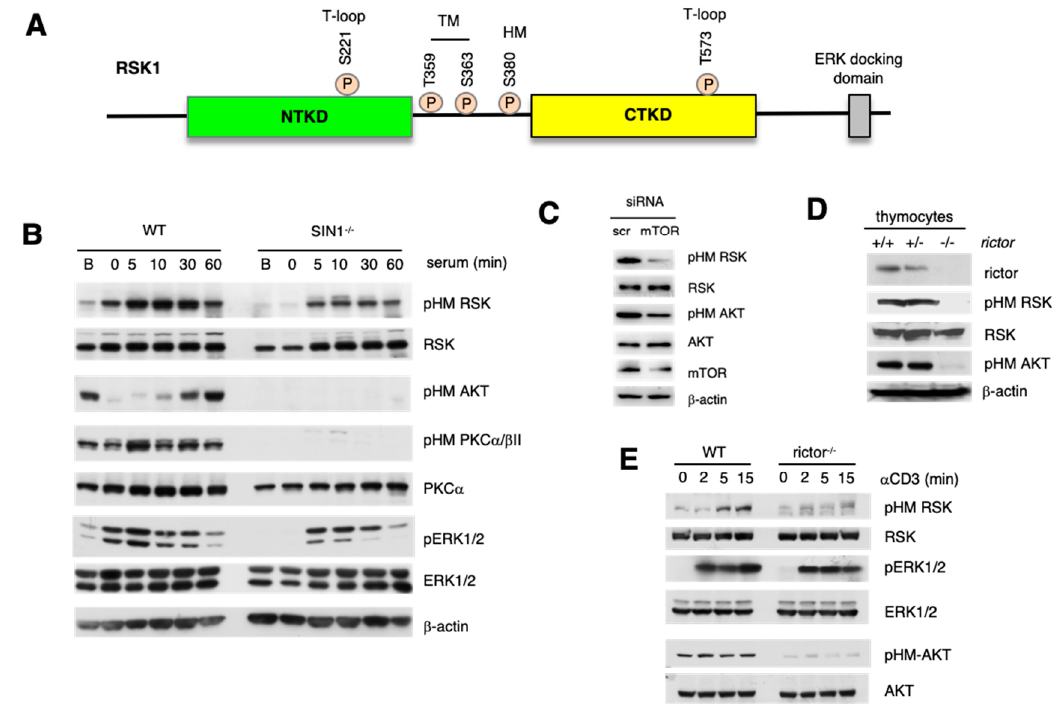
Figure 1. Phosphorylation of RSK at the hydrophobic motif site is diminished in mTORC2-disrupted cells. ( A ) RSK has two conserved catalytic domains, N-Terminal (NTKD) and C-Terminal (CTKD) kinase domains that are phosphorylated at each of their activation loops (T-Loop). These two domains flank a linker region that is conserved among AGC kinases containing the conserved turn (TM) and hydrophobic motifs (HM) that become phosphorylated at the indicated sites. ( B ) Wild type (WT) or SIN1 − / − MEFs were grown in complete DMEM (Basal; B) or grown then serum-starved overnight. Serum was re-added and cells were incubated for the indicated times (min) before harvest. Total lysates were prepared with CHAPS containing buffer and subjected to SDS-PAGE and immunoblotting using indicated antibodies. ( C ) HeLa cells were transfected with scramble control (scr) or siRNA targeting mTOR. Cells were lysed using RIPA and processed as in B . ( D ) Thymocytes with wild type (+/+), heterozygous (+/ − ) or homozygous ( − / − ) deletion of rictor were lysed and subjected to SDS-PAGE and immunoblotting. ( E ) Wild type (WT) or rictor-deficient thymocytes were non-stimulated (0) or stimulated with CD3 ε antibody (10 μ g/mL) for the indicated times (min).